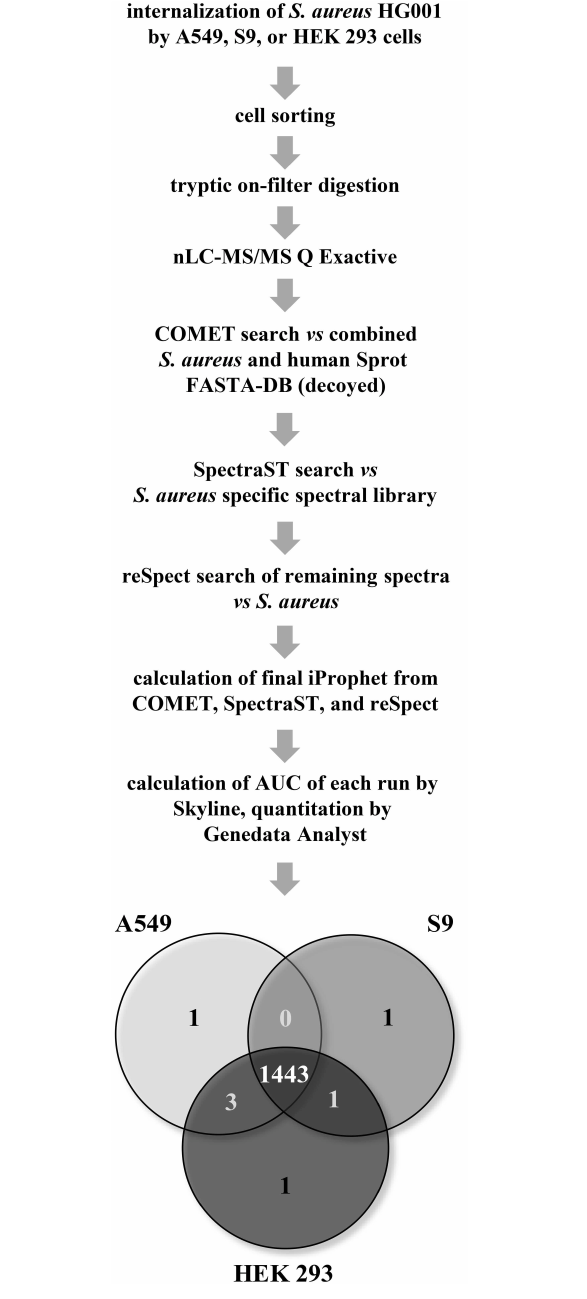
( Figure 4F ) and S9 ( Figure 4G ) cells than in S. aureus from HEK 293 cells 6.5 h p.i. ( Figure 4H